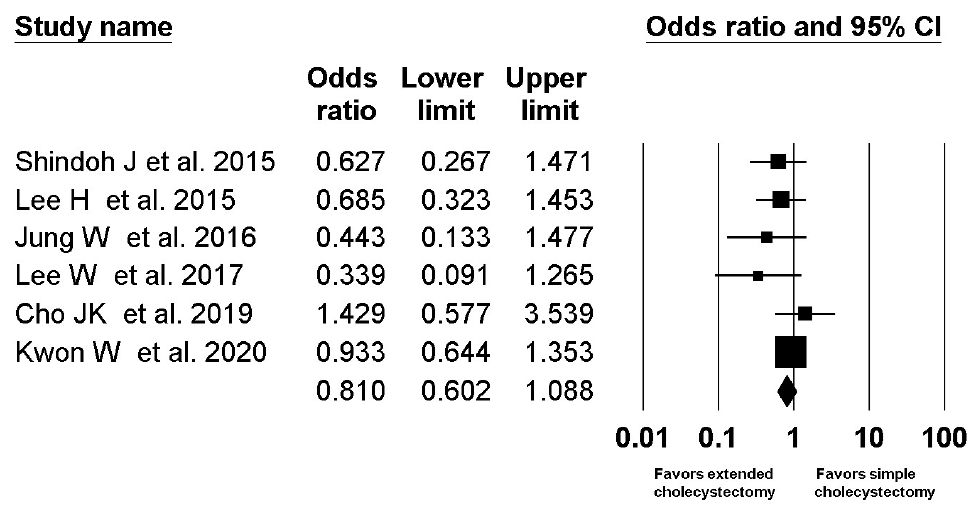
Figure 4. Forest plot of overall survival between extended cholecystectomy and simple cholecystectomy in T2b GBC patients. The figure depicts individual trials as filled squares with relative sample size and the 95% confidence interval (CI) of the difference as a solid line. The diamond shape indicates the pooled estimate and uncertainty for the combined effect.